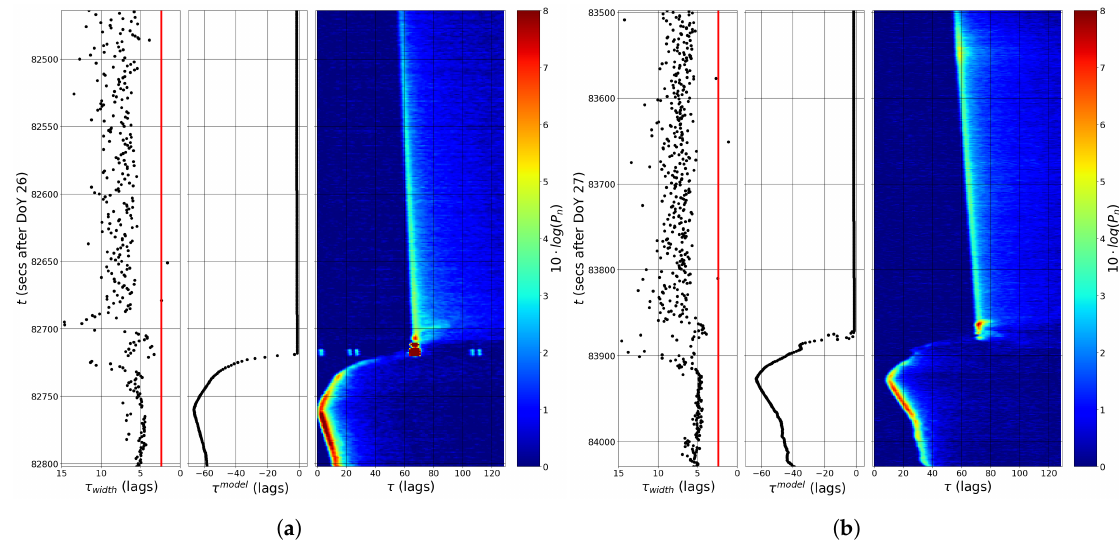
Figure 4. Two panels showing the time evolution of the power waveforms, one for each track. The left-hand figure in each panel contains the waveform widths τ width , defined at their 3-dB level. The vertical red line corresponds to the width of unscattered GPS C/A code signals. In the middle figure of each panel we show the modeled delay τ model as expected with respect to a reflection off a point on the reference WGS-84 ellipsoid. The model has assumed surface topographies provided by the EGM 2008 geoid over the sea and by NSIDC GLAS/ICESat over Greenland. In the right figure of each panel we present all the waveforms 2D image. ( a ) 26 January 2015. ( b ) 27 January